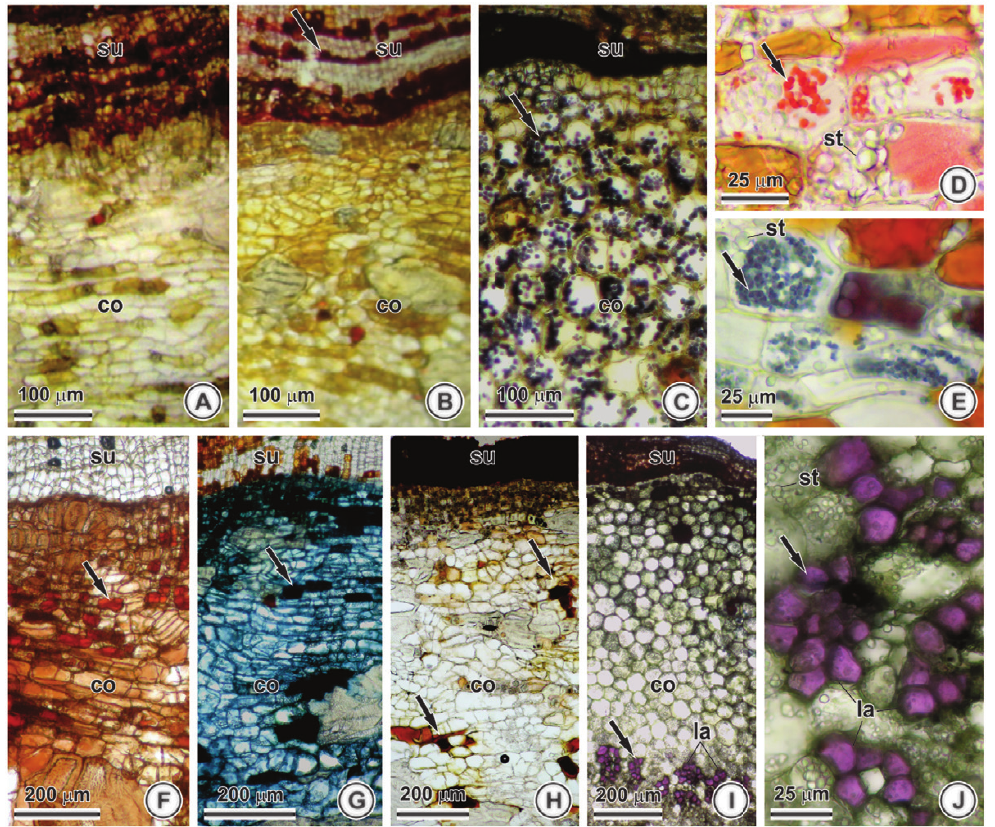
Figure 2 - Transverse sections of the bark of the underground stem of Tontelea micrantha subjected to different histochemical tests (arrows show positive reactions). (A) Material not subjected to any reagents (white). (B) Lipids stained red with Sudan IV (presence of carotenoids). (C) Starch grains stained purple with Lugol solution. (D, E) Proteins stained red with Ponceau xilidine and blue with bromophenol blue, respectively. (F) Tannin stained reddish-brown with vanillin hydrochloride. (G) Flavonoids stained blue with DMACA reagent. (H) Alkaloids stained reddish brown with Dittmar reagent. (I.J) Oleoresin stained pink with NADI reagent (arrow). co: cortex; la: laticifer; st: starch grain; su: